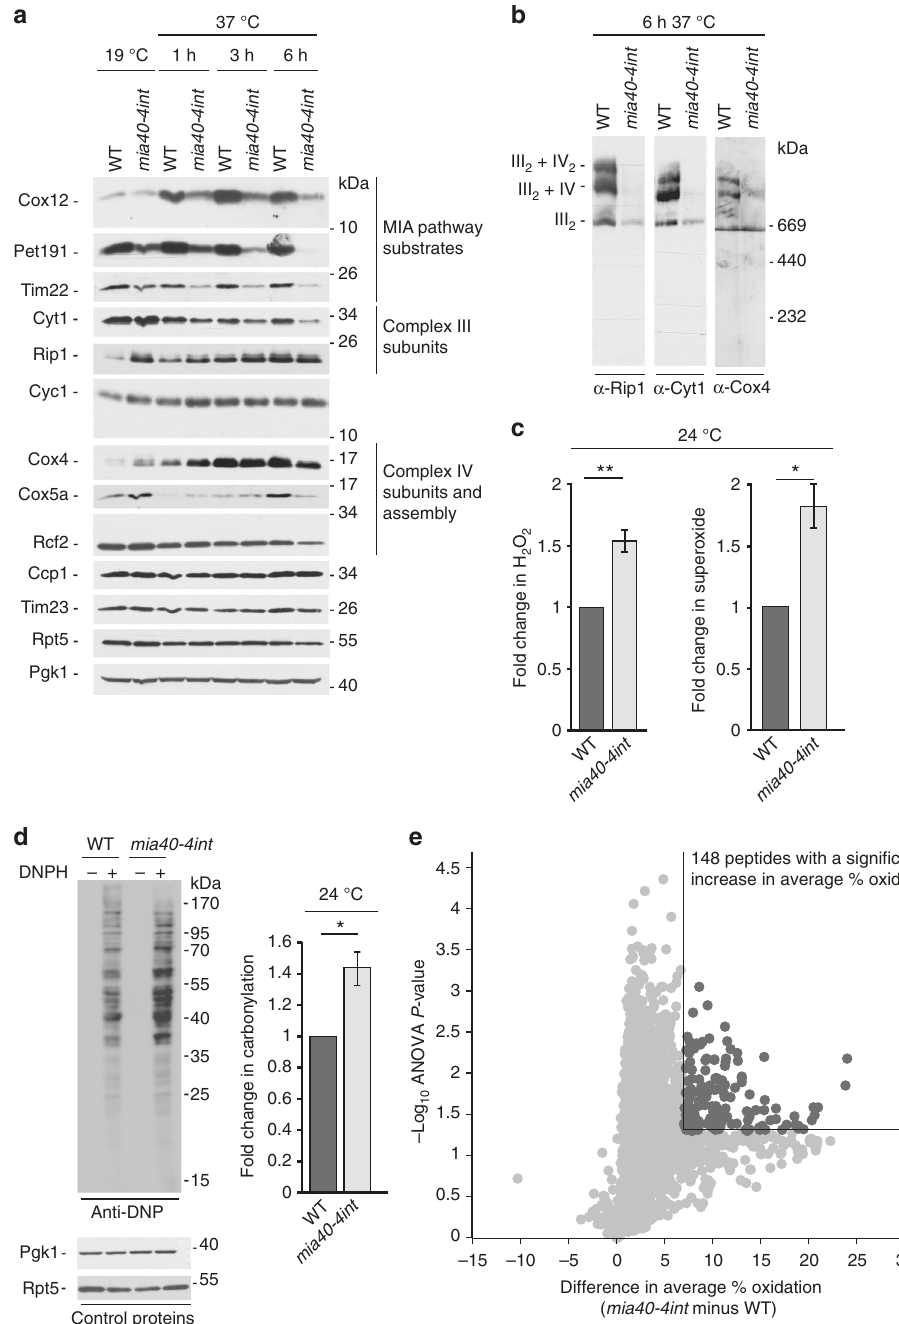
Fig. 4 MIA mutant shows increased levels of ROS. a Wild-type yeast and mia40-4int mutant were grown in respiratory medium at 19 °C and shifted to 37 ° C. Samples were collected at the indicated time points and analysed by immunoblotting. b Mitochondria were isolated from wild-type cells and mia40-4int mutant and analysed by Blue Native gel electrophoresis followed by immunoblotting. c Endogenous levels of H 2 O 2 and superoxide of wild-type cells and mia40-4int . Mean ± SEM, n = 3. * P- value < 0.04; ** P -value < 0.02; two-sided, paired t -test. d Carbonylation of proteins in wild-type cells and mia40-4int mutant was analysed by immunoblotting with anti-DNP antibody or quanti fi ed by spectrophotometry. Mean ± SEM, n = 3. * P- value < 0.05; two-sided, paired t -test. DNPH, 2,4-dinitrophenylhydrazine. e Volcano plot showing difference in average % oxidation ( mia40-4int minus wild-type) for 2,099 unique cysteine-containing peptides plotted against the − log 10 P- value (ANOVA test, n = 4). Cysteine-containing peptides with signi fi cantly increased oxidation levels are highlighted in dark grey (% oxidation ≥ 7, P- value < 0.05, n = 4). Lines indicate a difference in average % oxidation of ≥ 7 and a P- value of 0.05 ( − log 10 = 1.3). WT,